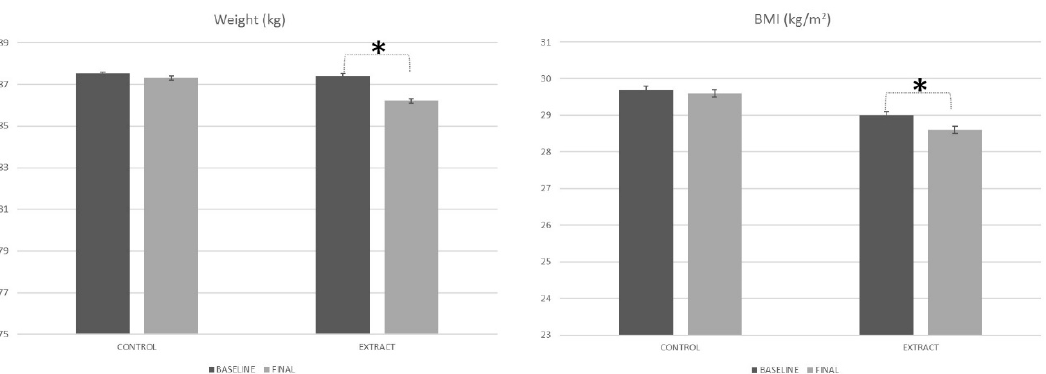
Figure 2. Weight and BMI evolution along the study. * Means statistically significant di ff erences.